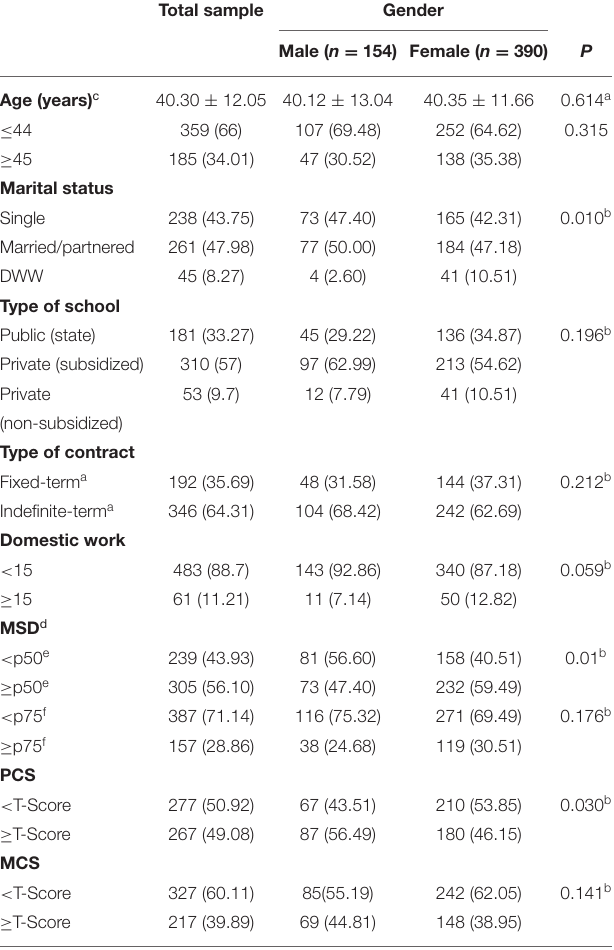
TABLE 1 | Sociodemographic characteristics, presence of musculoskeletal disorders and quality of life, evaluated by gender in Chilean